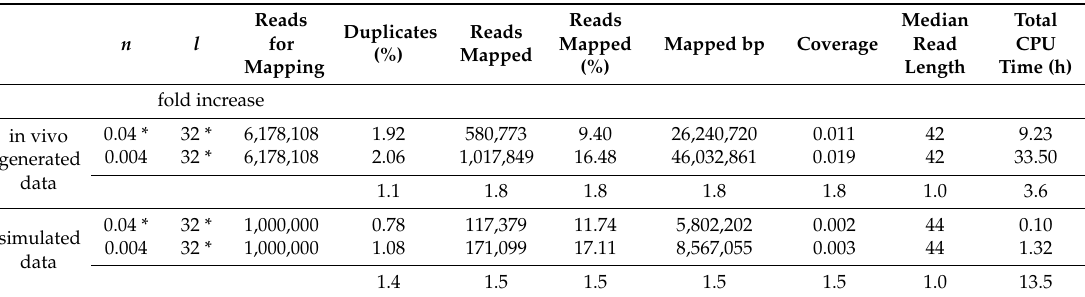
for the linsang